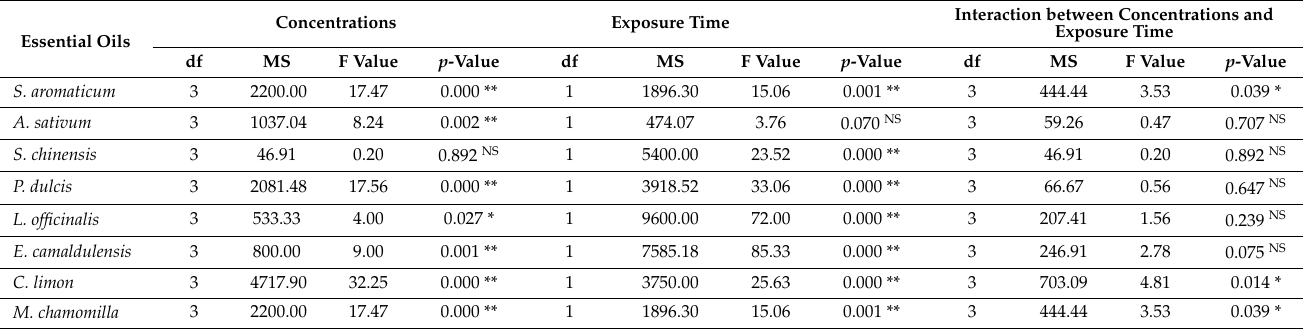
Table 2. Analysis of variance of different EOs of the tested insect’s